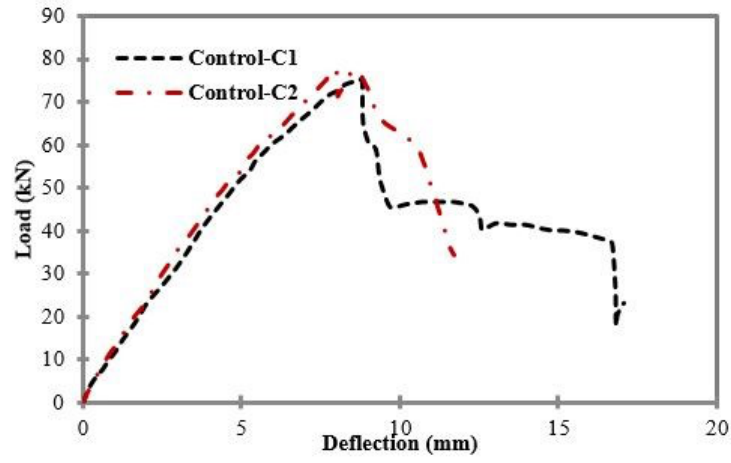
Figure 5. Load vs. mid-span deflection for control samples C1 and